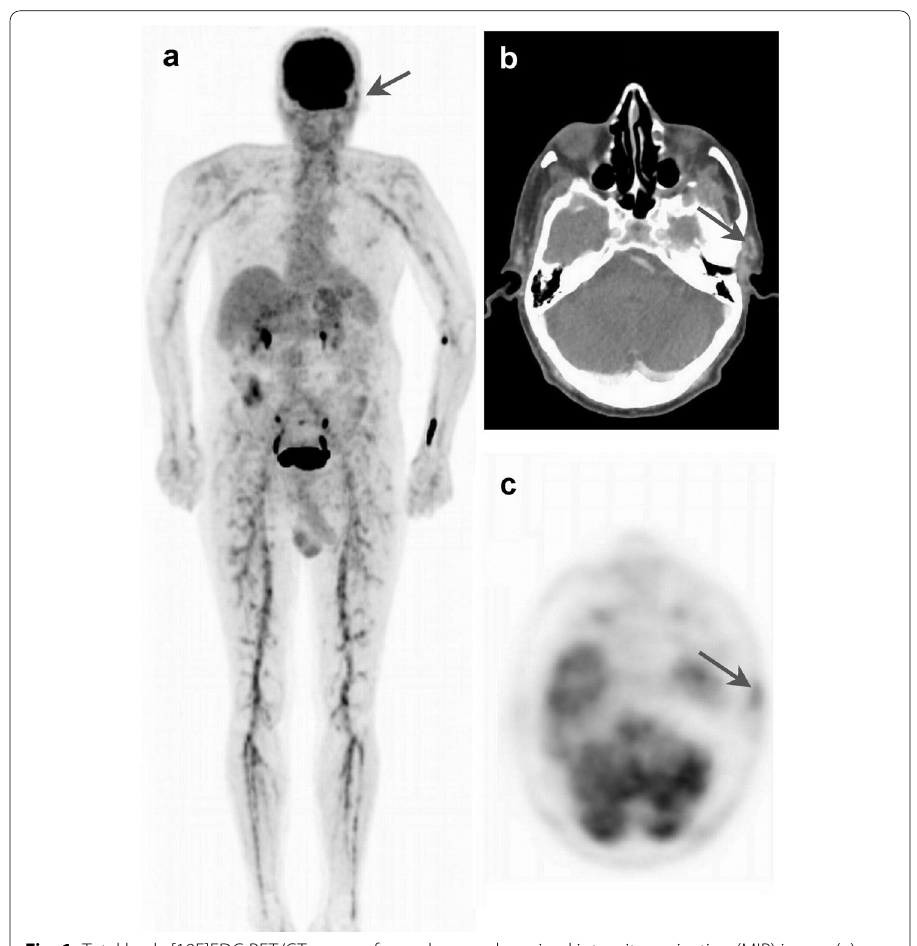
Fig. 1 Total body [18F]FDG PET/CT was performed; coronal maximal intensity projection (MIP) image ( a ) showed increased FDG uptake of moderate-intensity along medium-sized extra-cranial (maxillary, and superficial temporal arteries), and cranial vessels; corresponding axial contrast-enhanced CT and [18F] FDG-PET ( b, c ) showed involvement of the left temporal artery with pathological tracer uptake (arrow), indicating active